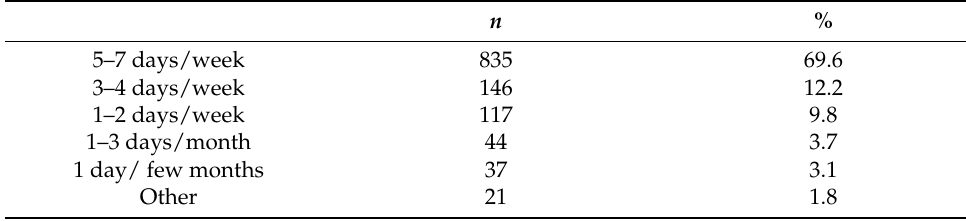
Table 9. Frequency of estrogen-like supplement use.